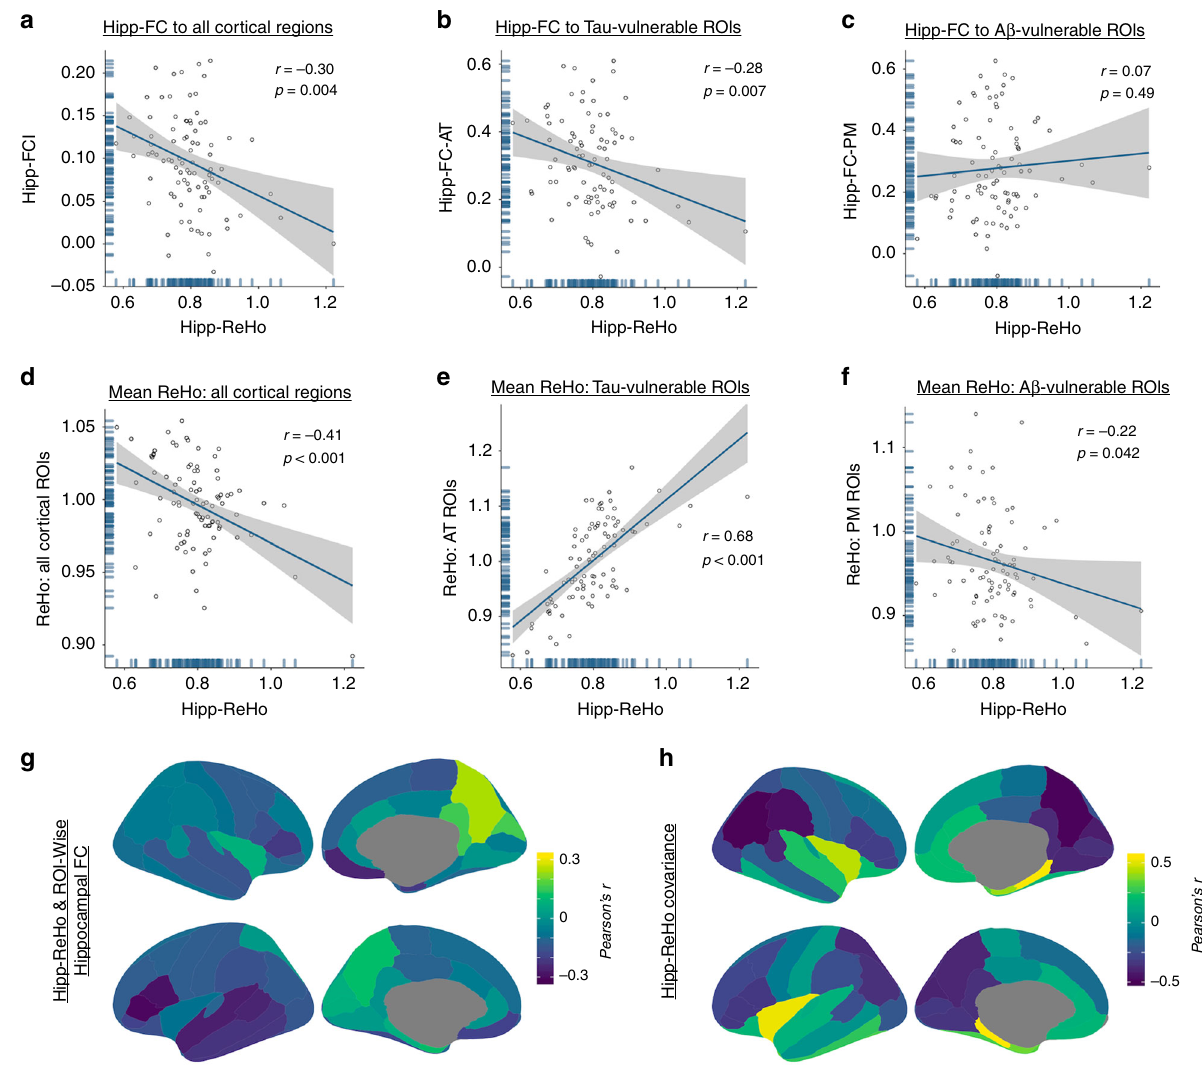
Fig. 4 Higher hipp-ReHo is associated with functional isolation of the hippocampus. a Hipp-ReHo and hipp-FCI, a measure of hippocampal connectivity averaged over the entire cortex, were negatively correlated ( r = − 0.30, p = 0.004; all r and p -value pairs re fl ect Pearson correlation). b Hipp-ReHo was negatively correlated to hipp-FC-AT, a measure of hippocampal connectivity to AT regions ( r = − 0.28, p = 0.007). c There was no relationship between hipp-ReHo and hipp-FC-PM ( r = 0.07, p = 0.49). d Hipp-ReHo negatively predicted mean ReHo across all cortical ROIs ( r = − 0.41, p < 0.001). e Hipp- ReHo was positively correlated to mean ReHo in AT regions ( r = 0.68, p < 0.001). f Hipp-ReHo negatively predicted mean ReHo in PM regions ( r = − 0.22, p = 0.042). g Across OA participants, the correlation between hipp-ReHo and hippocampal FC to each cortical ROI indicated that increasing hipp-ReHo was related to decreasing FC between hippocampus and temporal cortex. h Across OA participants, hipp-ReHo covariance to ReHo in each cortical ROI showed that higher hipp-ReHo was associated with increased ReHo in temporal cortex. Source data are provided as a Source Data fi le. hipp-FCI hippocampal functional connectivity index, hipp-ReHo hippocampal ReHo, Hipp-FC hippocampal functional connectivity, AT anterior temporal, PM posterior medial, hipp-FC-AT hippocampal FC to tau-vulnerable AT regions, hipp-FC-PM hippocampal FC to A β -vulnerable PM